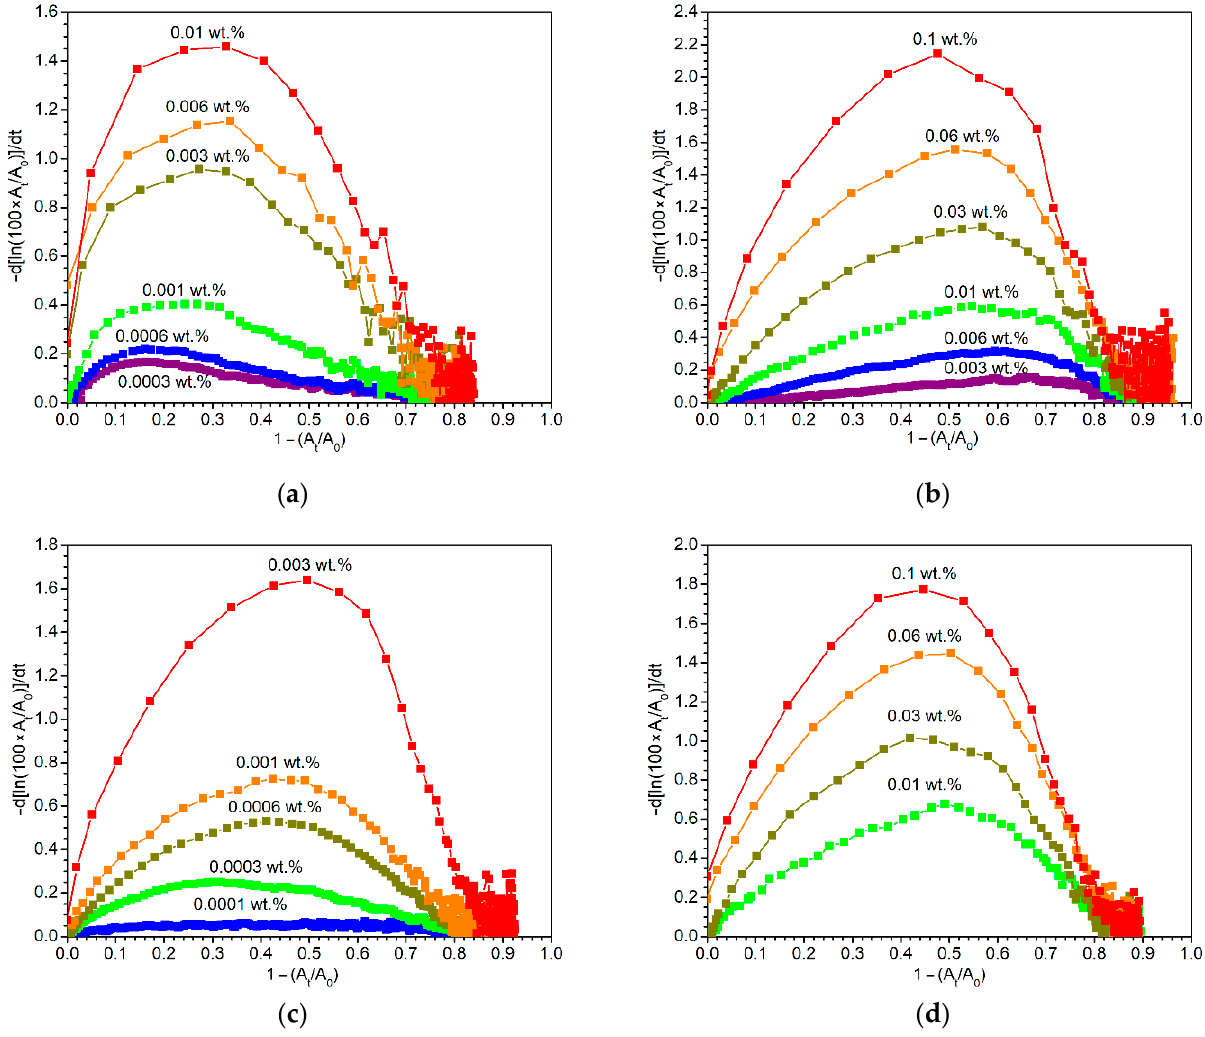
Figure 6. Dependence of rate coefficient (in h − 1 ) on conversion for formulations of S471 treated by ( a ) Fe-diiPc; ( b ) Co-2EH; ( c ) Borchi OXY-Coat; ( d ) Mn(acac) 3 .